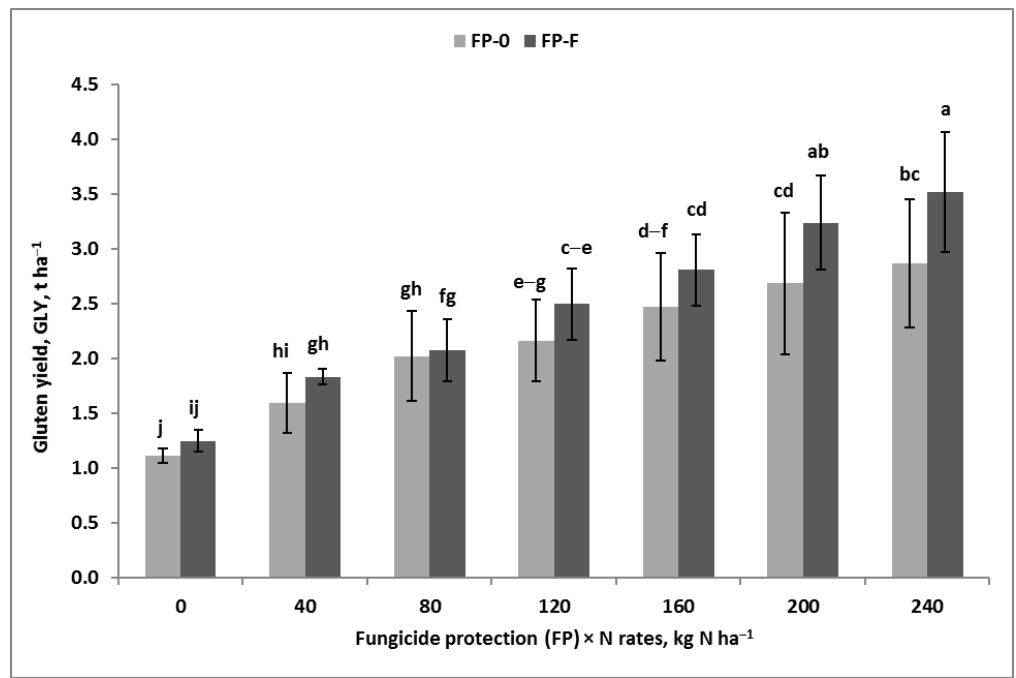
Figure A2. The content of protein in winter wheat grain in consecutive years of study on the back- ground of plant protection. Similar letters in the column means a lack of significant differences using Tukey’s’ test . The vertical bar in the column refers to the standard error of the mean.